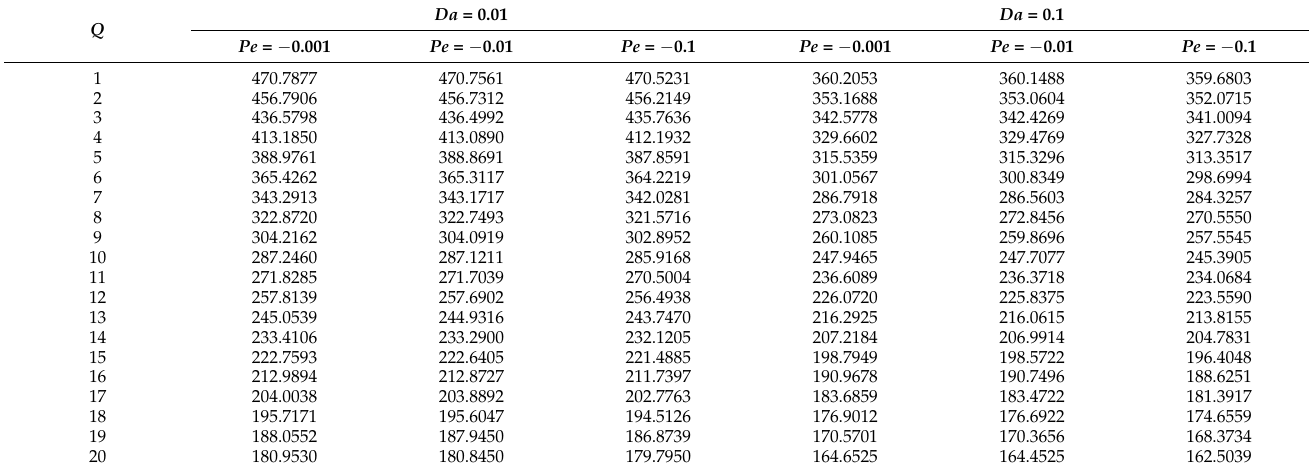
Figure 2. Dependence of Ra c on Q for ( a ) Da = 0.01 and ( b ) Da = 0.1. Table 4 shows the Ra c for different Q and Pe , along with fixed Da = 0.01, Da = 0.1 and Ta = 50. Figure 3 illustrates a visual behavior of these values. The results for downward